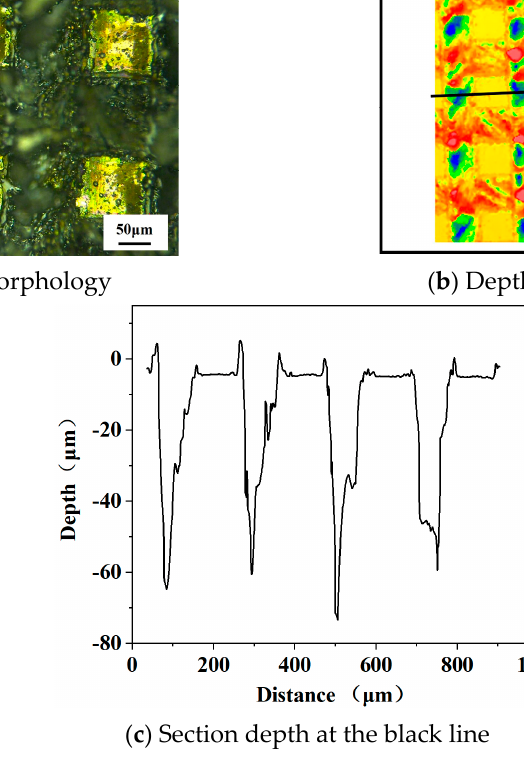
Figure 4. Experimental results of laser processing (Average power = 8 W, pulse width = 40 ns, frequency = 150 kHz, scanning speed = 100 mm/s).